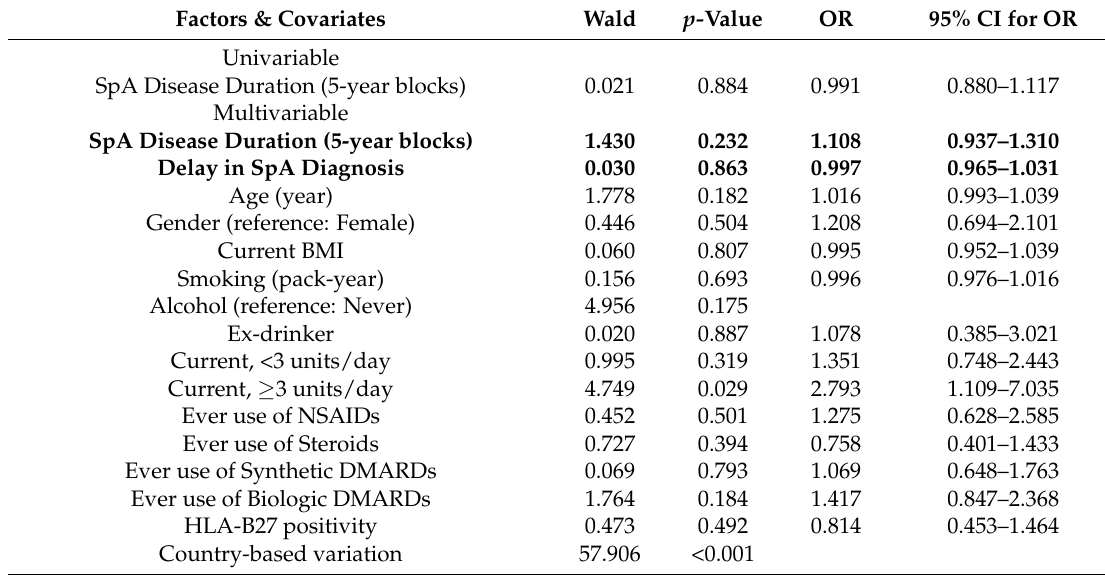
Table 4. Risk of hepatitis B (HBV) infection associated with longer disease duration in participants with